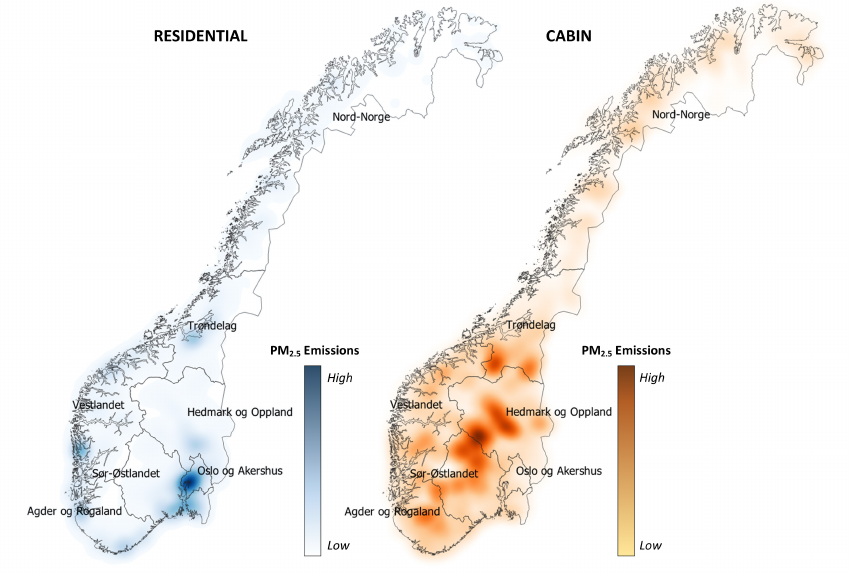
Figure 6. Spatial distribution of emissions from RWC ( left ) and CWC ( right ) for heating. Note that the colorbar has a different scale for cabins and